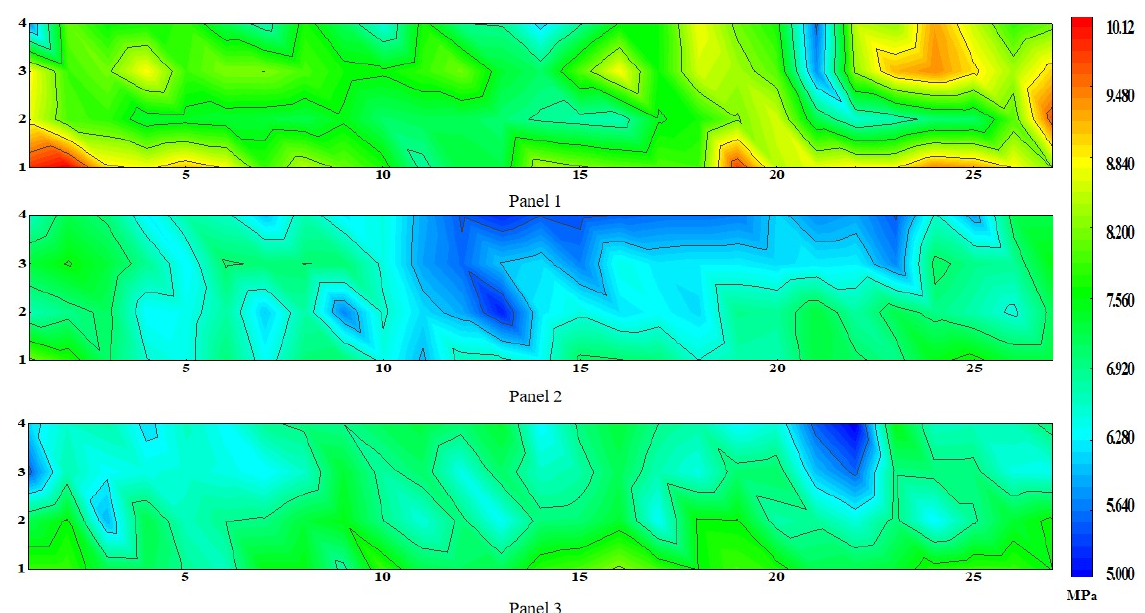
Figure 9. Compressive strength distribution nephogram.